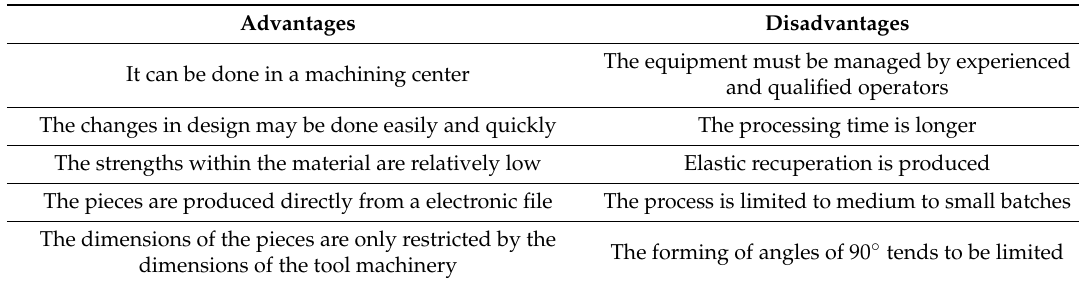
Table 1. Advantages and disadvantages of single point incremental formation (SPIF)